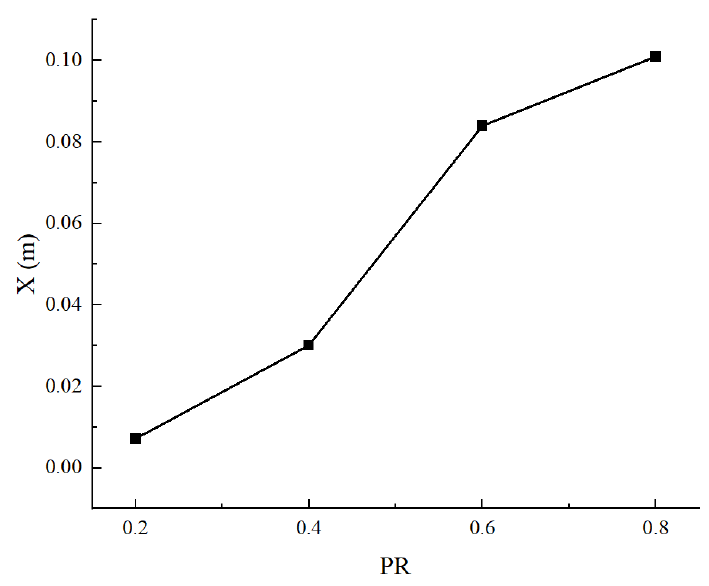
Figure 11. Position of reattachment point.